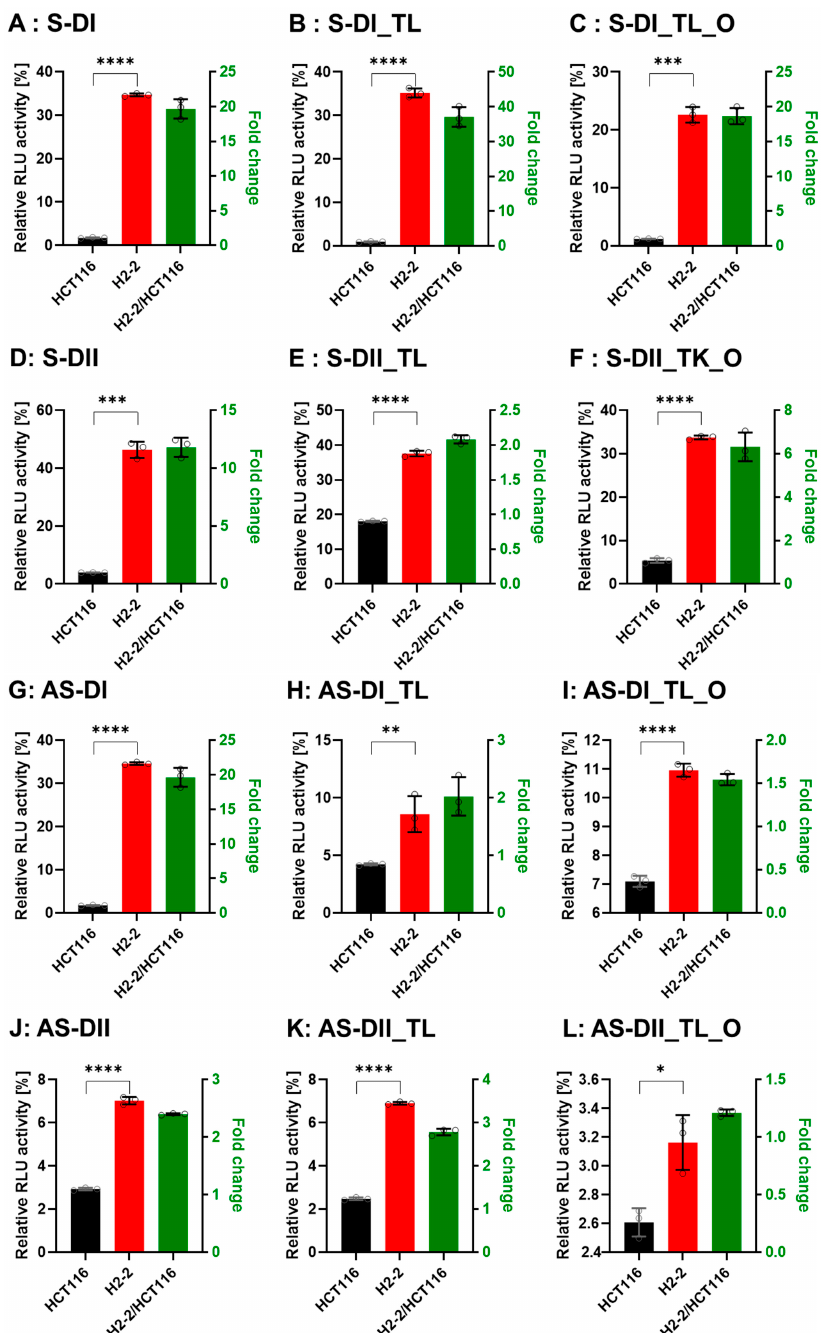
Figure 7. Comparison of DsiRNA efficacy in HCT116 and Dicer knockout H2-2 cells. The detection method used was the same as in Figure 6. We transfected the dual-luciferase reporter and DsiRNAs into HCT116 (black) and Dicer knockout H2-2 (red) cells. We determined the fold decrease of gene silencing efficiency in H2-2 by calculating the activity of H2-2 divided by HCT116 (green bar), as represented on the right y-axis. Graphs show the gene silencing activity of sense (S) strands (A–F) of A: DI, B: DI_TL, C: DI_TL_O, D: DII, E: DII_TL, and F: DII_TL_O, and antisense (AS) strands (G– L) of G: DI, H: DI_TL, I: DI_TL_O, J: DII, K: DII_TL, and L: DII_TL_O. Data represent the mean ± S.D. of three independent experiments (Student’s t -test * p < 0.05, ** p < 0.01, *** p < 0.001, and **** p < 0.0001).